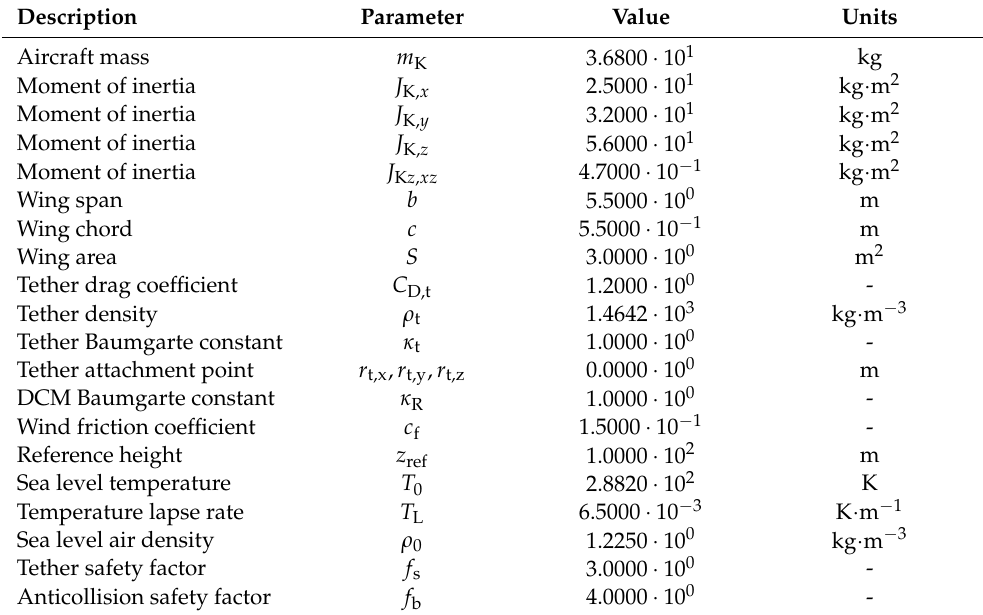
Table A1. System